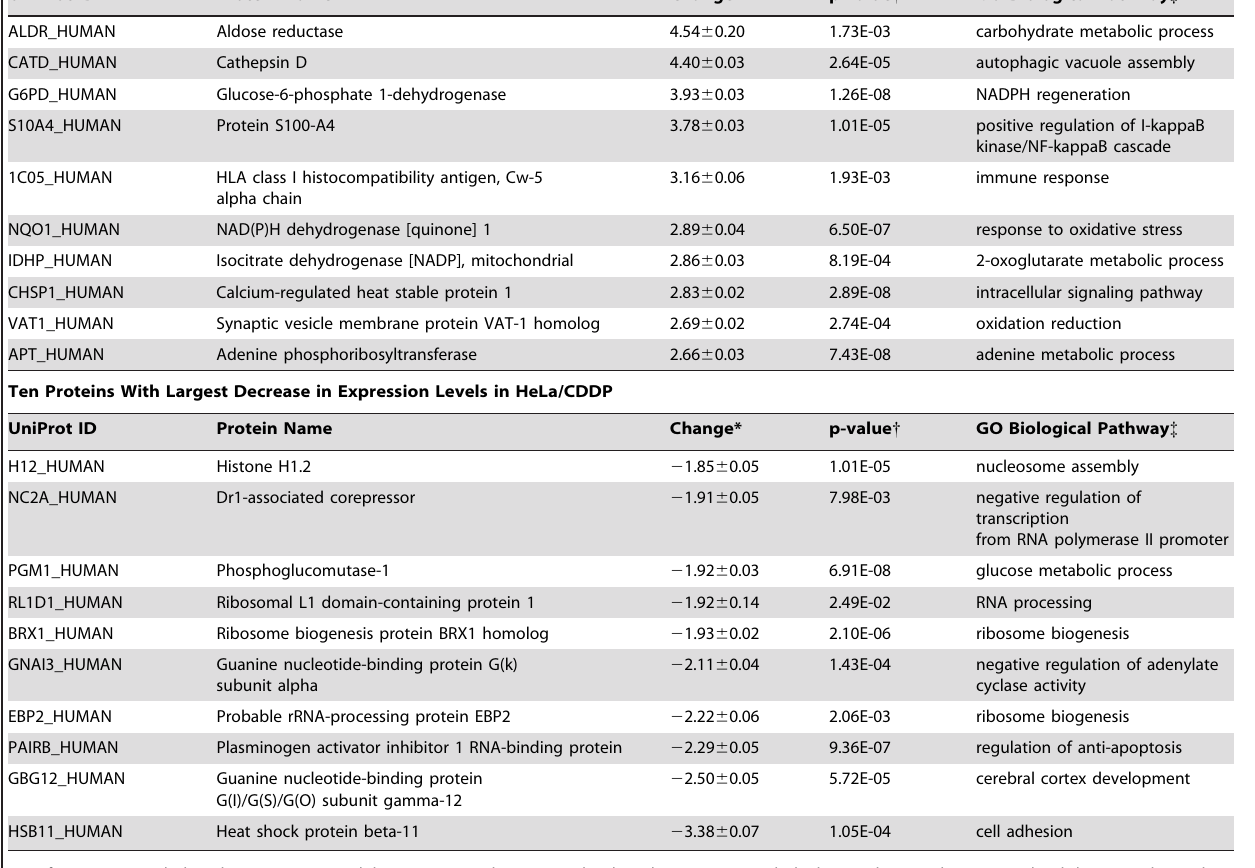
{ First biological pathway Gene Ontology term associated with protein.